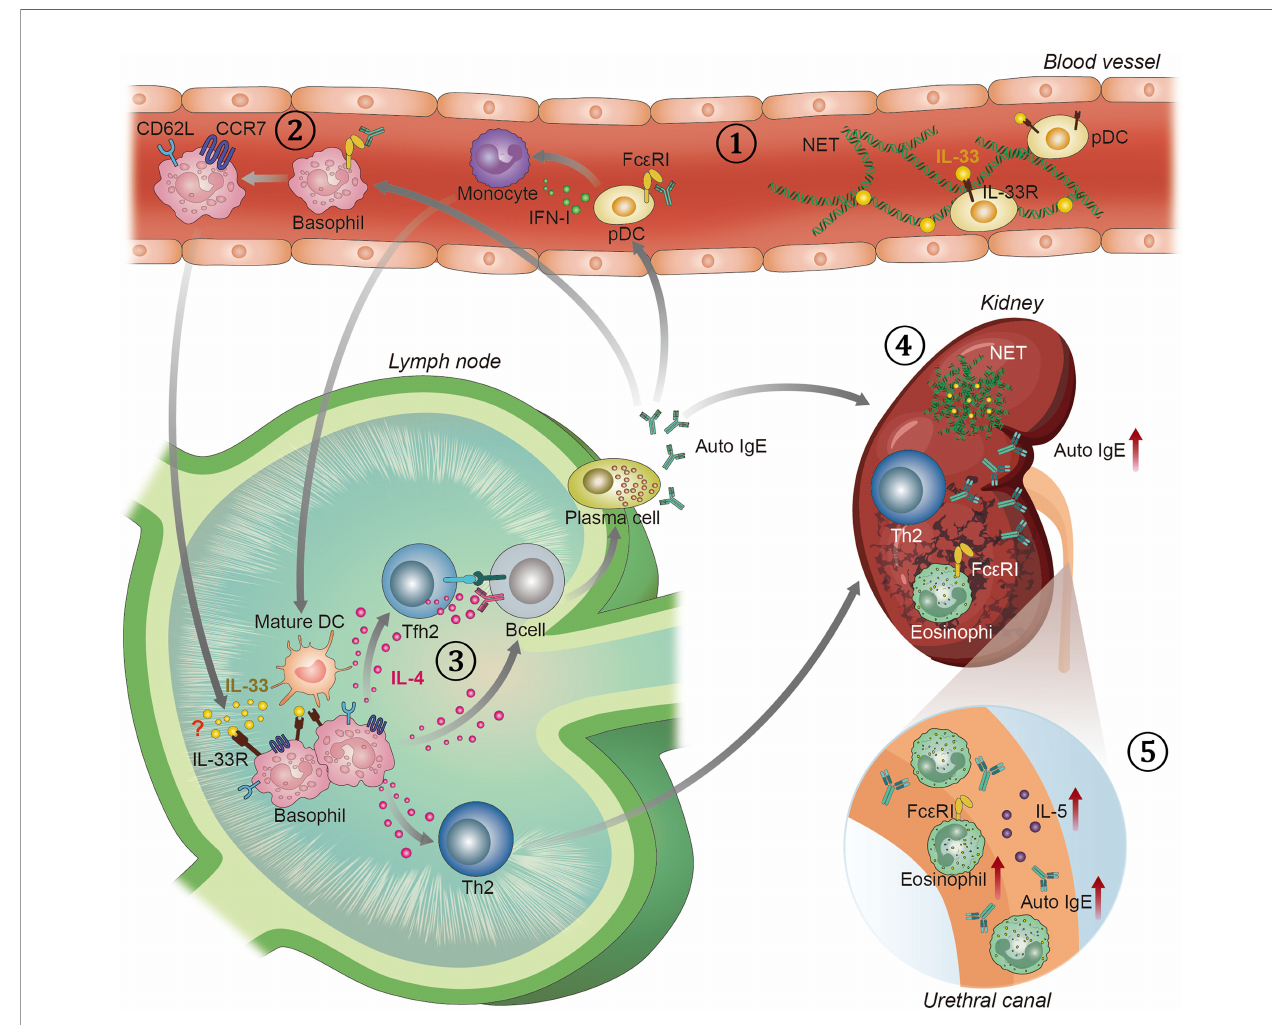
FIGURE 1 | Overview of T helper 2 associated immune response in SLE. 1) SLE patients have elevated levels of NETs decorated with bioactive IL-33 and auto-IgE in blood. They are potent in activating pDCs to produce IFN-I, which are known to play key role in the pathogenesis of SLE. Activated pDCs stimulate monocytes to differentiate into mature DCs. 2) Auto-IgE also stimulates basophils to drain into SLOs by upregulating CD62L and CCR7. 3) In SLO, basophils polarize T cells into Th2 and Tfh2 cells, and activate B cells in IL-4 dependent manner. Tfh2 cells promote the differentiation of B cells into IgE autoantibody-producing plasma cells.